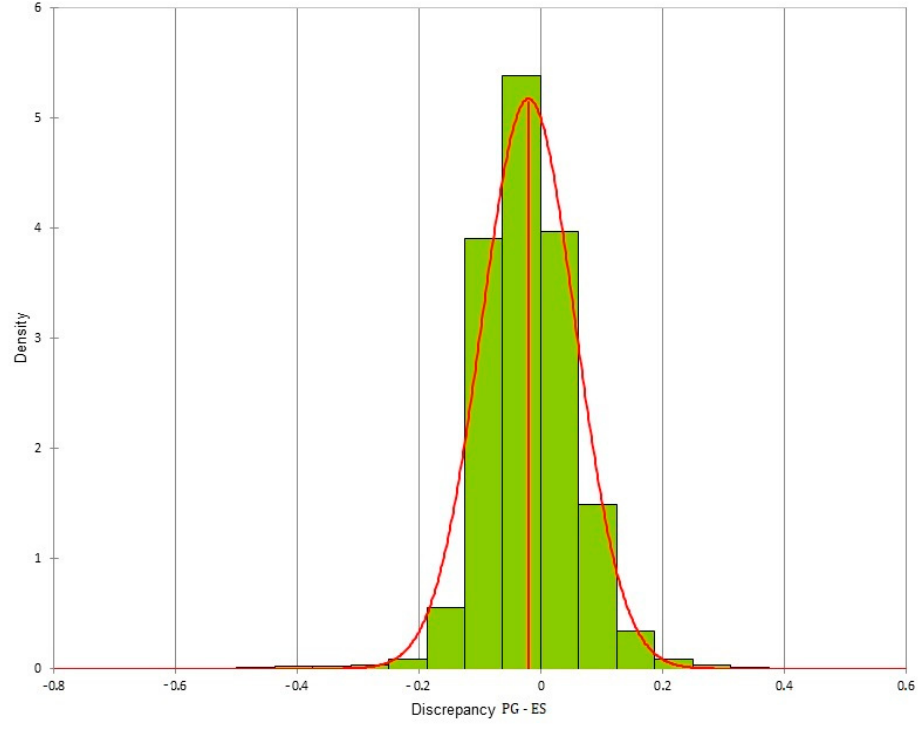
Figure 11. Histogram of the discrepancy between photogrammetry and dental extraoral laboratory scanner.